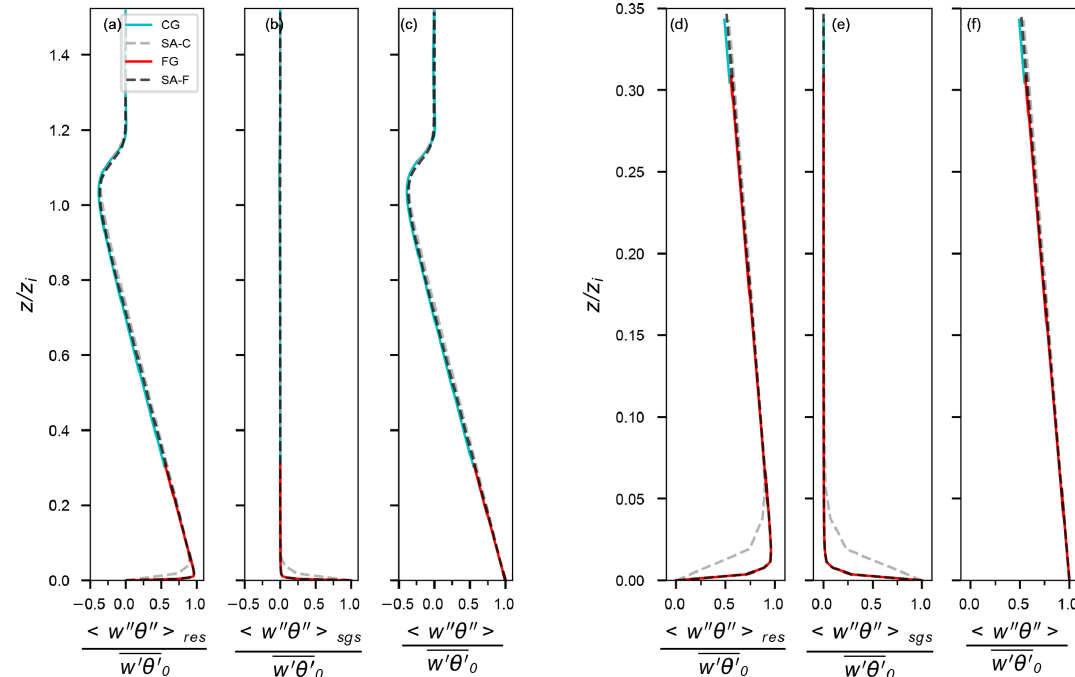
Figure 6. Vertical profile of horizontally averaged heat flux normalized by the surface heat flux – resolved (a, d) , sub-grid (b, e) and total flux (c, f) . The two-way nesting significantly improves the resolved and SGS fluxes in the surface layer. Table 5. Grid configuration of the nested and non-nested FG domain. Nested Non-nested FG